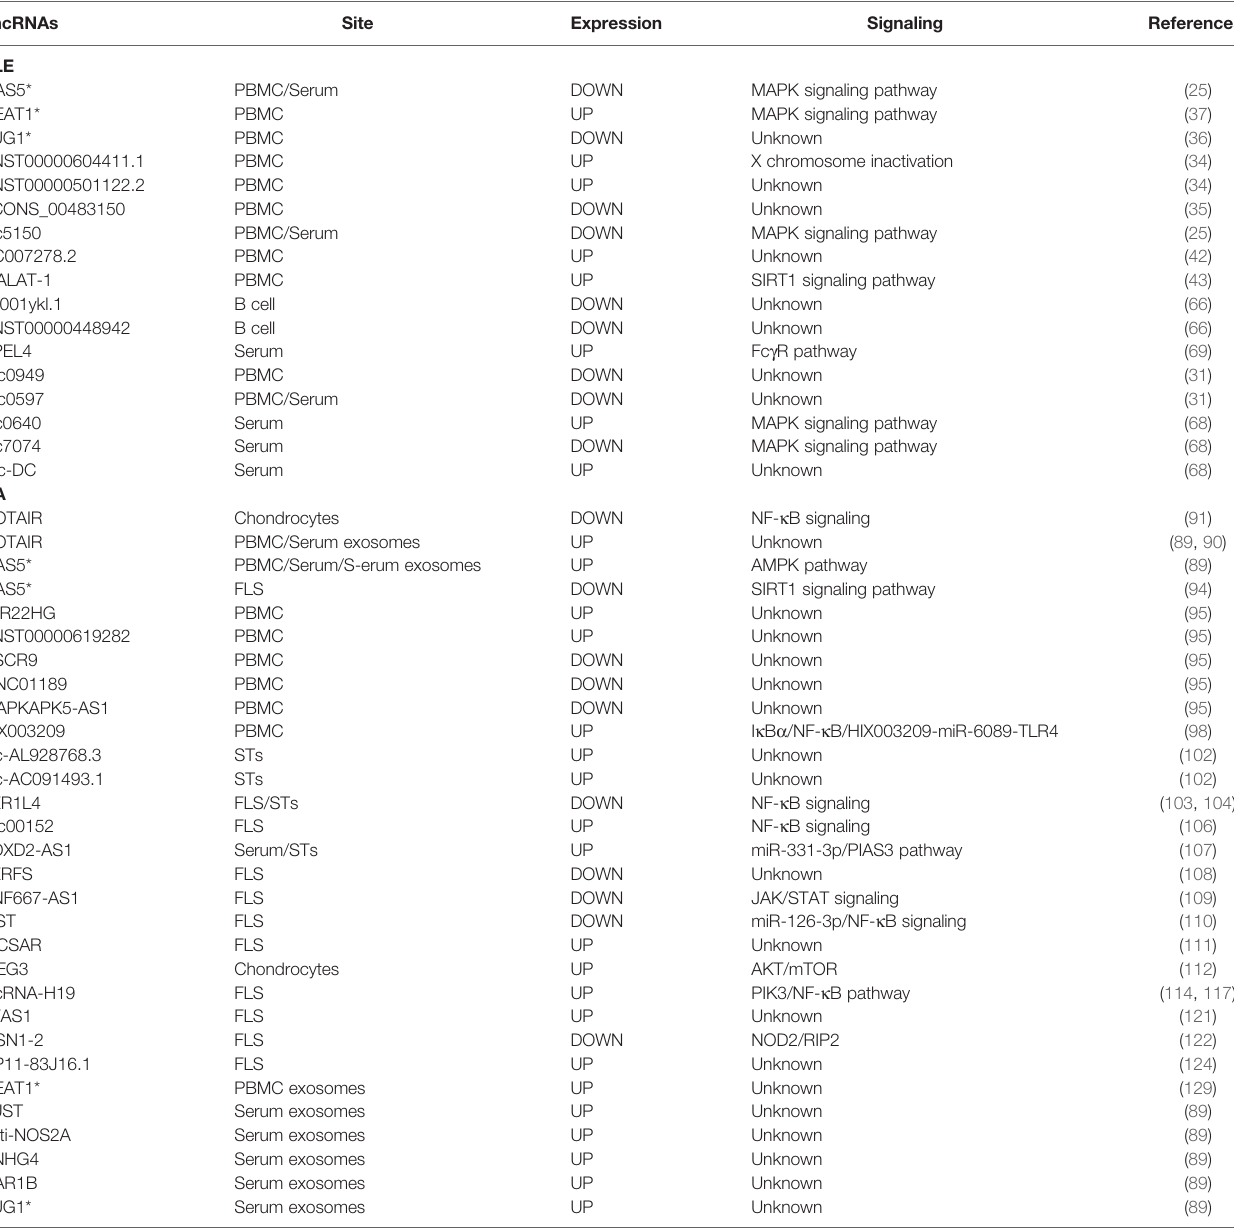
TABLE 1 | LncRNAs implicated in SLE and